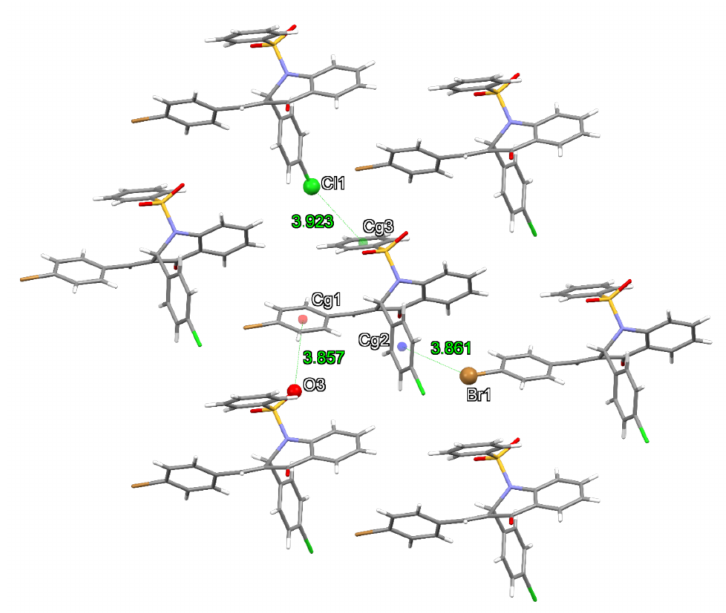
Figure 4. Contacts involving aromatic rings in the QBCP structure.